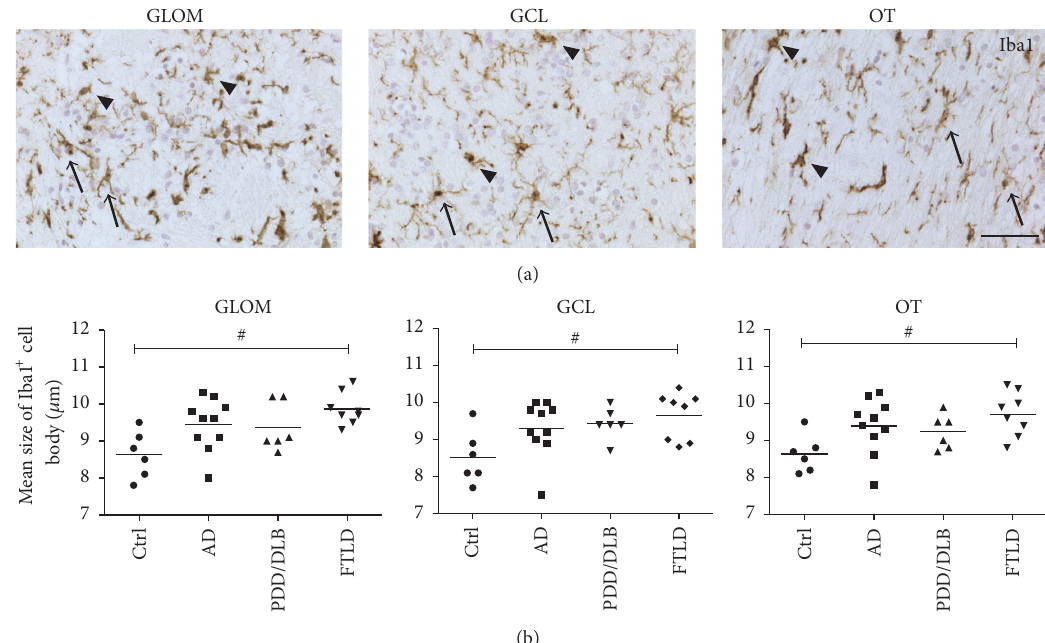
Figure 4: Analysis of the size of Iba1+ cell somata in the GLOM, GCL, and OT of the OB in respective neurodegenerative diseases. (a) Example images of Iba1+ microglia in all three regions of the OB, showing resting Iba1+ cells with smaller cell somata and long processes (arrows), compared to activated Iba1+ microglia with an increased cell soma size and short or no processes (arrowheads). (b) While the mean diameter ( 𝜇 m) of somata of Iba1+ microglial cells was not significantly increased in all regions of AD and PDD/DLB cases, cell somata were significantly larger in FTLD compared to controls, suggesting an activation of Iba1+ microglia in FTLD. 1-way ANOVA, Kruskal Wallis post hoc test, # 𝑝 < 0.05 . Scale bar represents 50 𝜇